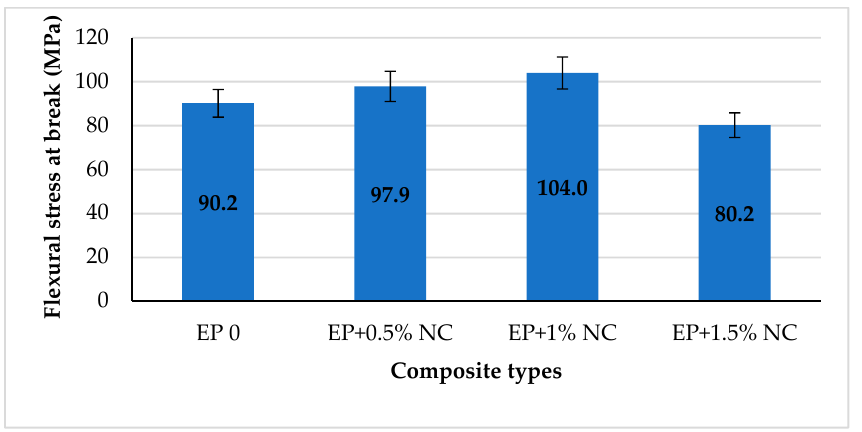
Figure 7. Flexural stress at break for epoxy composites with NC. Flexural stress at break is a parameter that determines the value of the force needed to break the sample. The graph shows that it increases to 1% NC content and then de- creases as the number of modifiers increases. The maximum flexural stress at break was obtained at 1% NC content, about 15% higher than unmodified epoxy resin. Therefore, the strength properties of the sample increase to a certain limit amount of nanofiller. Too much nanocellulose has a negative effect on the sample properties. Figure 8 summarizes the results of the dependence of flexural strain at break with different nanocellulose contents.